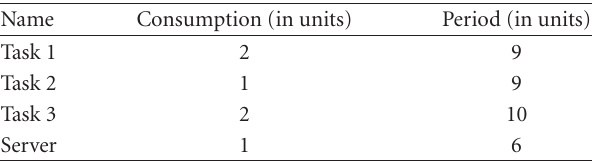
Table 1: First example for Priority